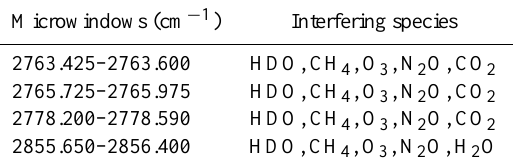
Table 1. List of the microwindows used for the FTIR retrieval of HCHO and the interfering species. The 2765 and 2855cm − 1 mi- crowindows are used in a first run to pre-fit HCHO, HDO and O 3 by simple scaling. The scaled profiles of these three compounds are then used as a priori profiles in the retrievals of